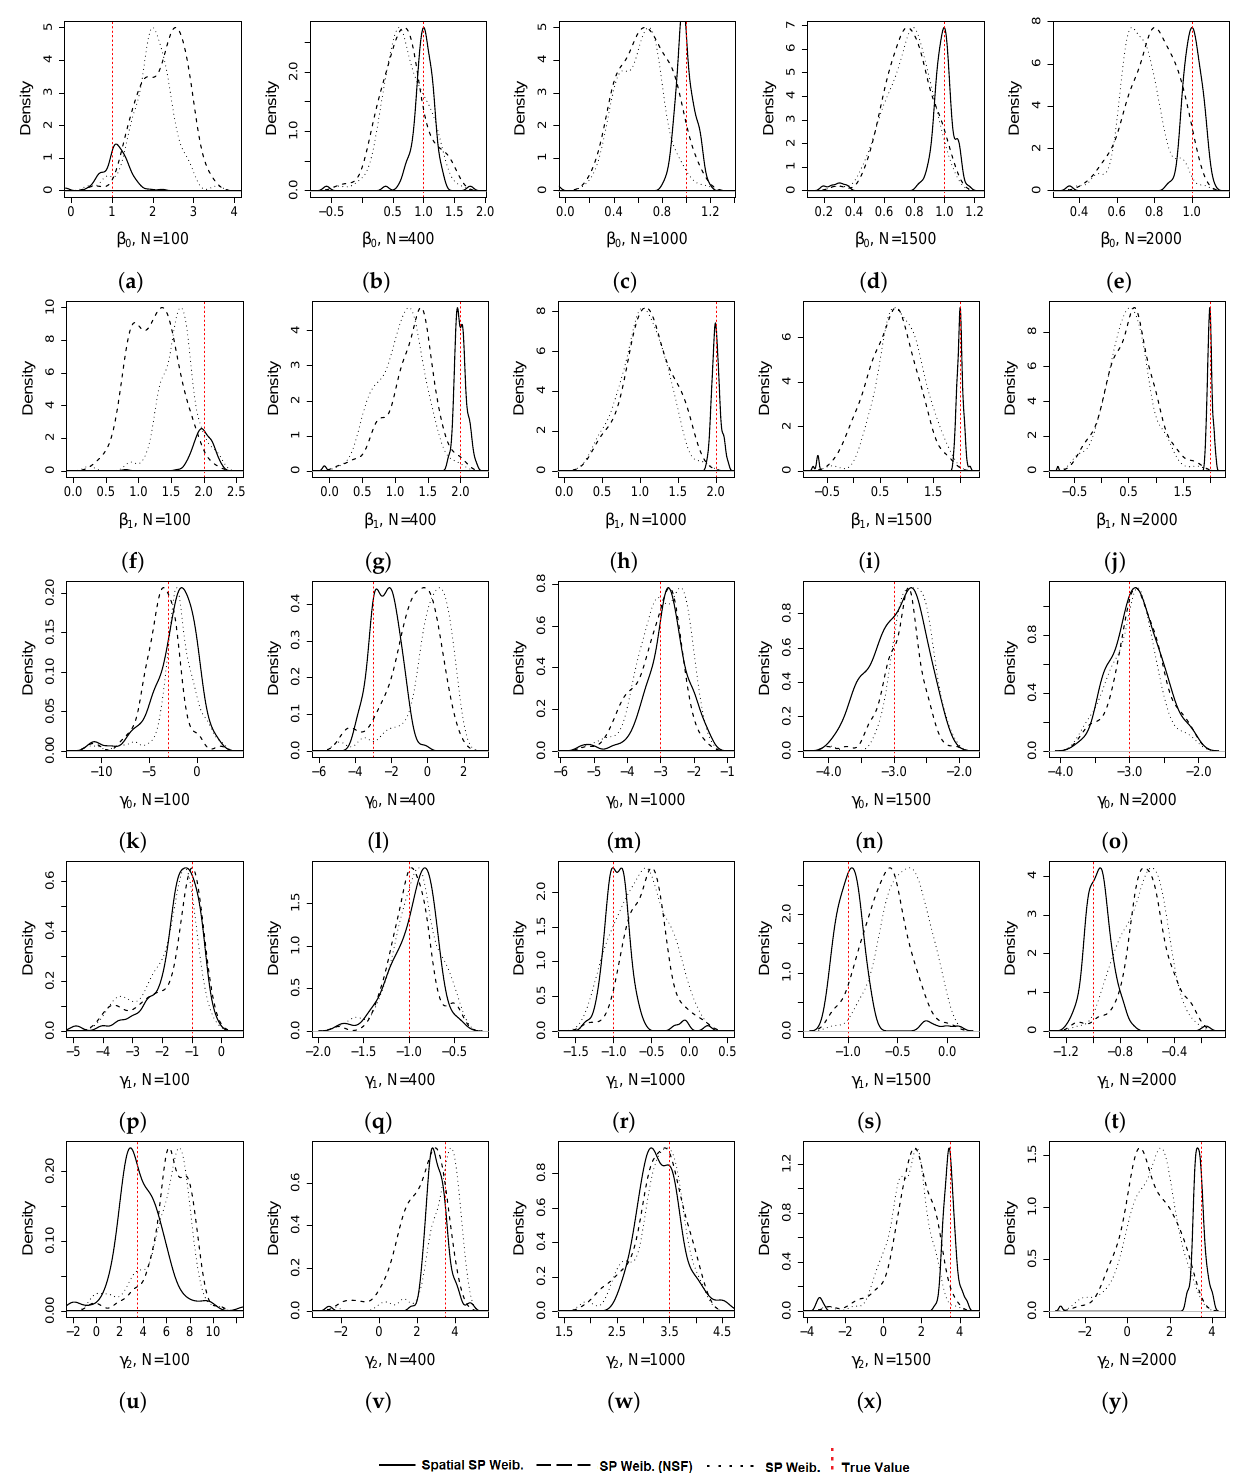
Figure 1. MC Experiment 1 β , γ densities for SP Weibull, NS Frailty Weibull, and Spatial SP Weibull models for: ( a ) ˆ β 0 , N = 100, ( b ) ˆ β 0 , N = 400, ( c ) ˆ β 0 , N = 1000, ( d ) ˆ β 0 , N = 1500, ( e ) ˆ β 0 , N =